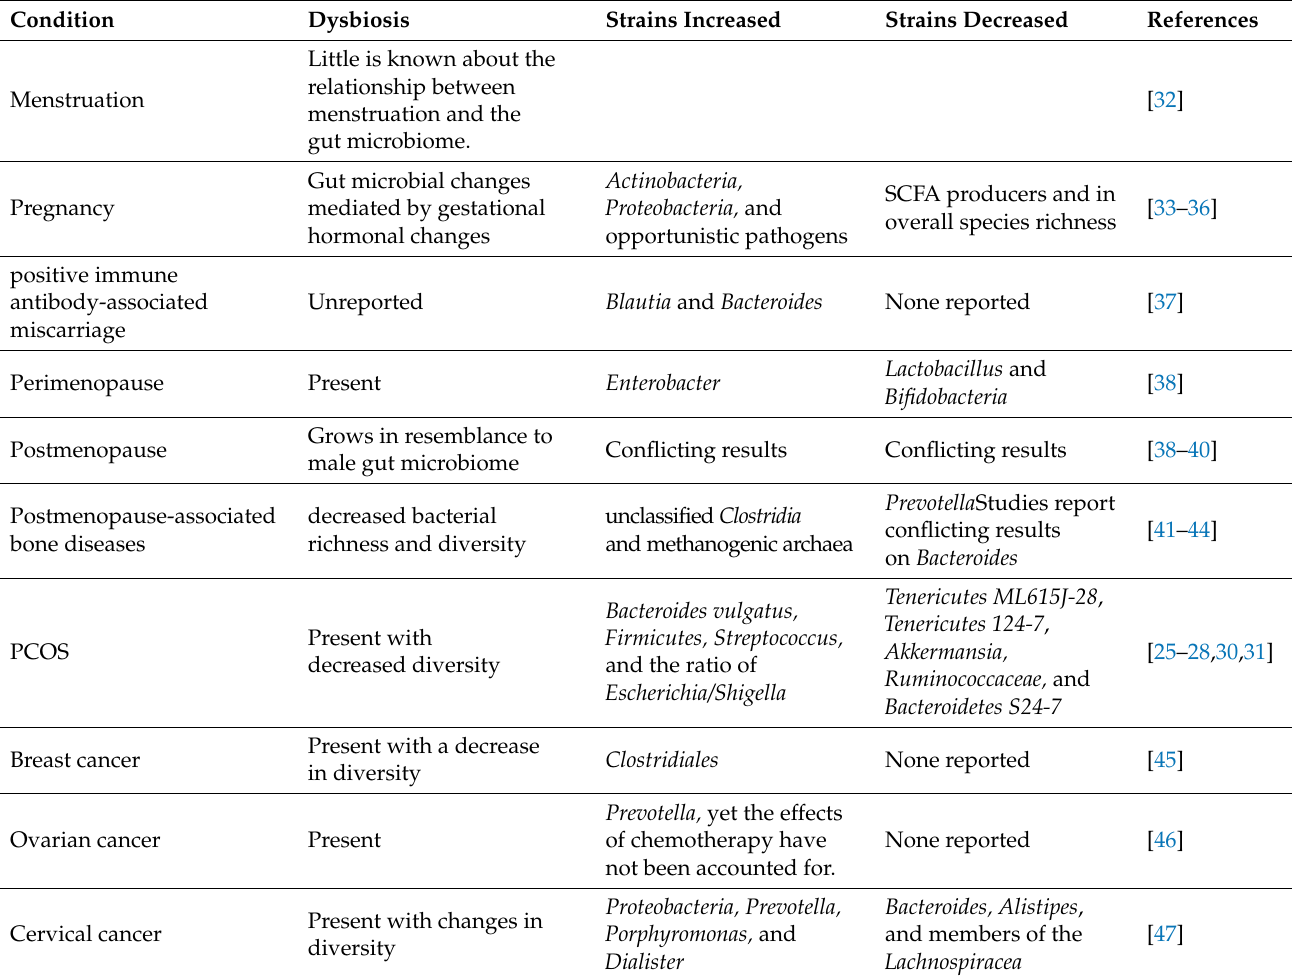
Table 1. The impact of gut microbiota on female